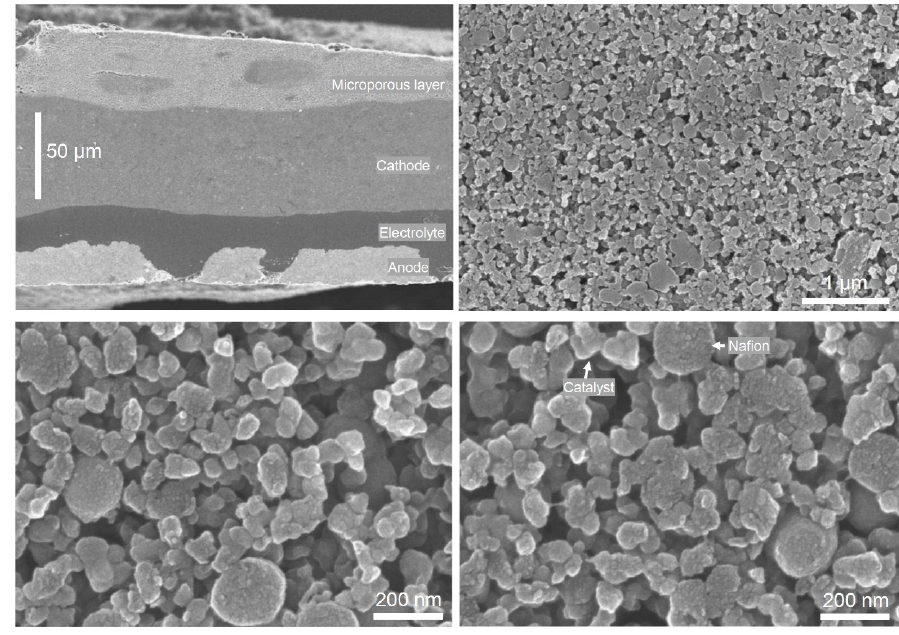
Figure 9. Cross-sectional scanning electron microscopy (SEM) image of the membrane electrode assembly (MEA) with the Fe(2.0)/PI(60) cathode catalyst.